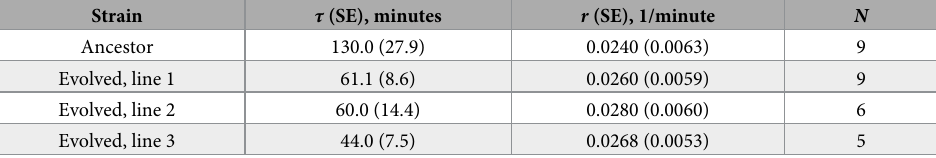
Table 1. Estimates for colonization time ( τ ) and in vivo growth rate ( r ) for ancestral and early-evolved (passage 4) isolates. Strain τ (SE), minutes r (SE), 1/minute N Ancestor 130.0 (27.9) 0.0240 (0.0063) 9 Evolved, line 1 61.1 (8.6) 0.0260 (0.0059) Evolved, line 2 60.0 (14.4) 0.0280 (0.0060) Evolved, line 3 44.0 (7.5) 0.0268 (0.0053) 5 N = number of time points combined for determination of mean and